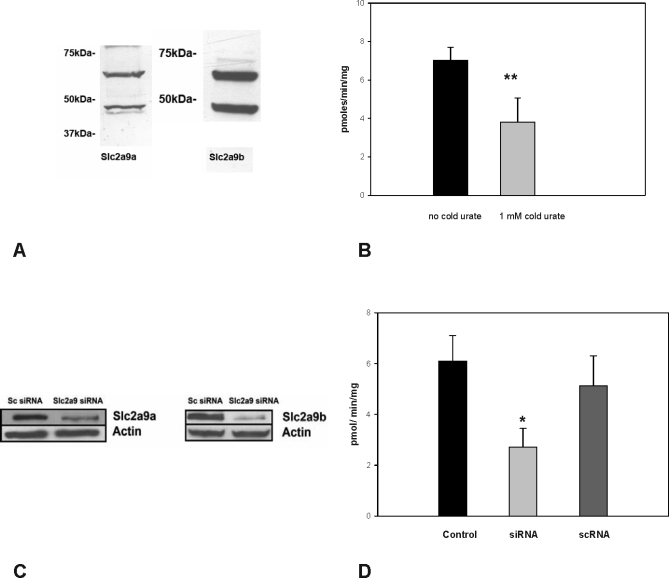
Expression of SLC2A9 and Urate Uptake into Mouse Insulinoma MIN6 Cells(A) Western blotting of mouse SLC2A9 in MIN6 cells. Cell lysates were analyzed by Western blot using antibodies to murine SLC2A9a and SLC2A9b of MIN6 cell lysates.(B) 14C-urate uptake into MIN6 cells is competitively inhibited by cold urate. Radiolabelled urate uptake was measured in mouse insulinoma cells, which endogenously express mSLC2A9a or mSLC2A9b. Uptake of 14C-urate, 120 μM, was measured for 6 min at 37 °C in the presence or absence of an additional 1mM cold urate. ** p < 0.02.(C) SLC2A9a and SLC2A9b expression is reduced by treatment of MIN6 cells with siRNA specific for mSLC2A9. Cells were treated with either scrambled RNA (scRNA) or mSLC2A9-specific siRNA and cell lysates run on a Western blot and probed with an antibody specific for either mSLC2A9a (mGLUT9a) or mSLC2A9b (mGLUT9b).(D) Reduction of urate uptake into MIN6 cells by transfection with siRNA targeted to SLC2A9. MIN6 cells were transfected with either SLC2A9-specific siRNA9 or scrambled RNA (scRNA). 14C-urate, 120 μM, uptake into transfected or untransfected cells was measured for 6 min at 37 °C. *p < 0.05.